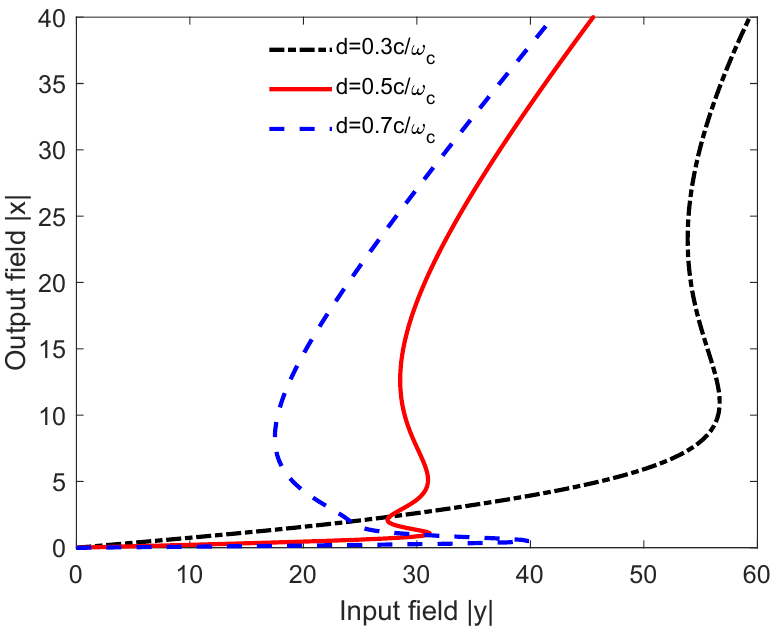
Figure 4. Plots of the input–output field curves for the quantum sample (emitter + metasurface) for different distances d of the emitter from the plasmonic metasurface. We take ¯ ω = 0.632 ω p , ω 32 = 0.25 Γ 0 , r = 0, C = 100 and δ = 0.35 Γ 0 .